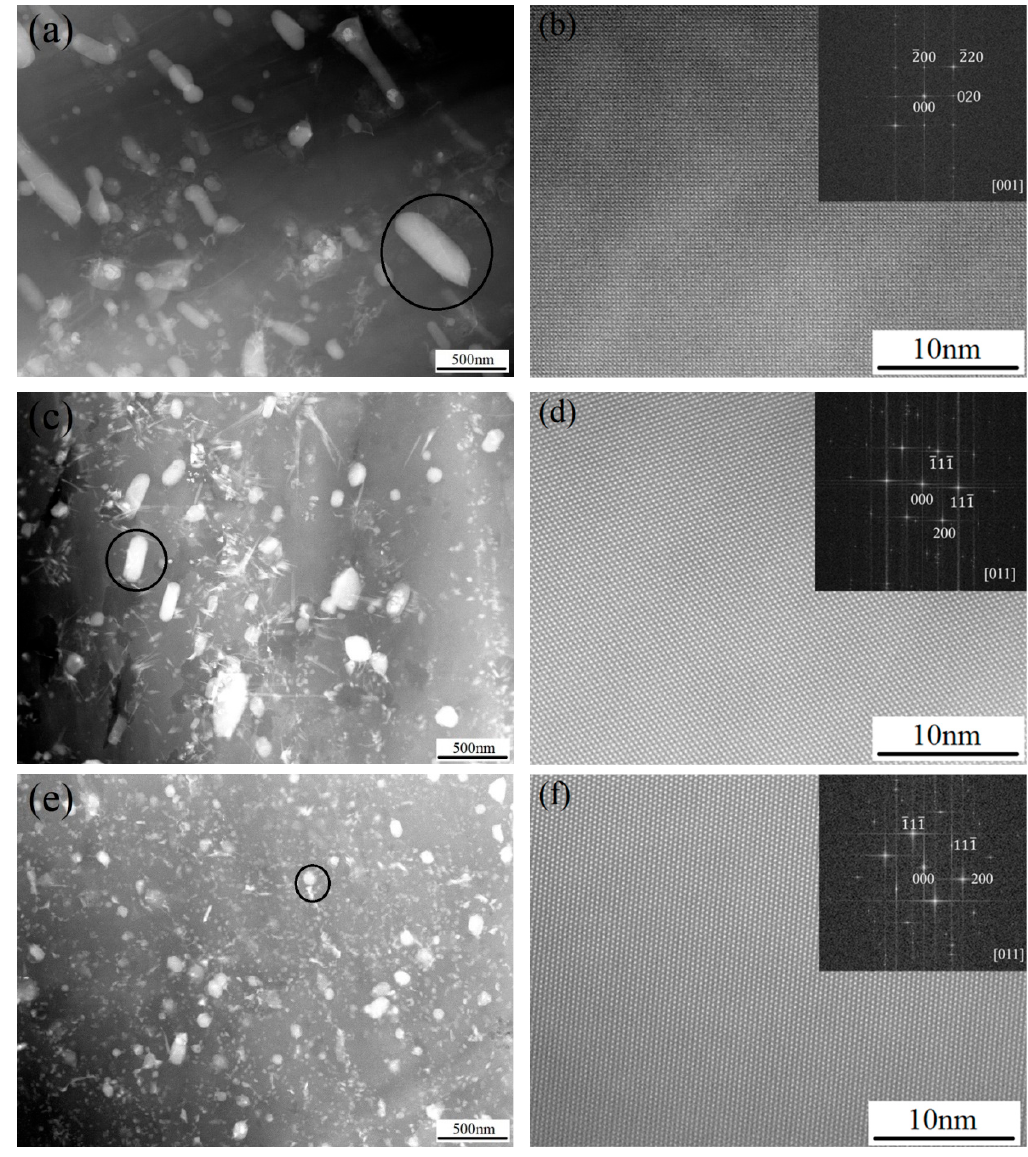
Figure 9. TEM results of as-extruded Mg-Sn alloys: ( a , b ) Mg-6Sn; ( c , d ) Mg-6Sn-2Zn; and ( e , f )